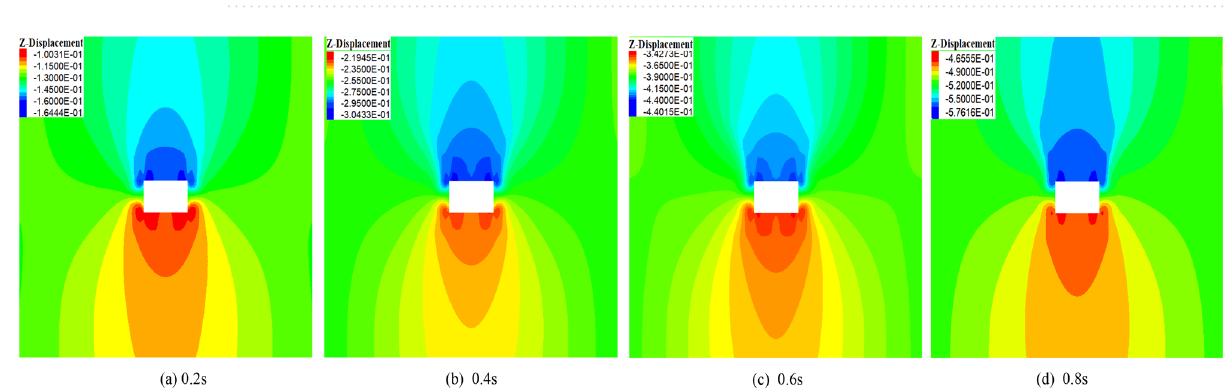
Figure 10. The law of surrounding rock failure types under different disturbance frequencies.